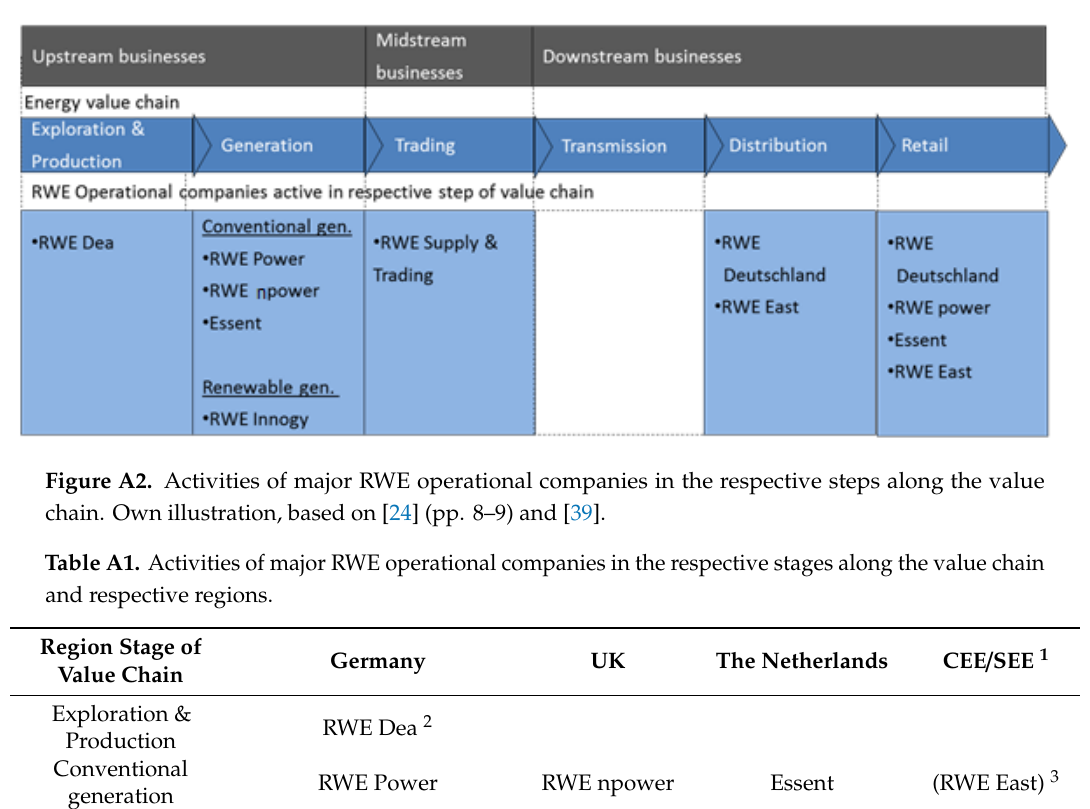
Figure A1. Example for a qualitative checklist approach on vertical integration. Based on [18] (pp. 15, 19), modified.